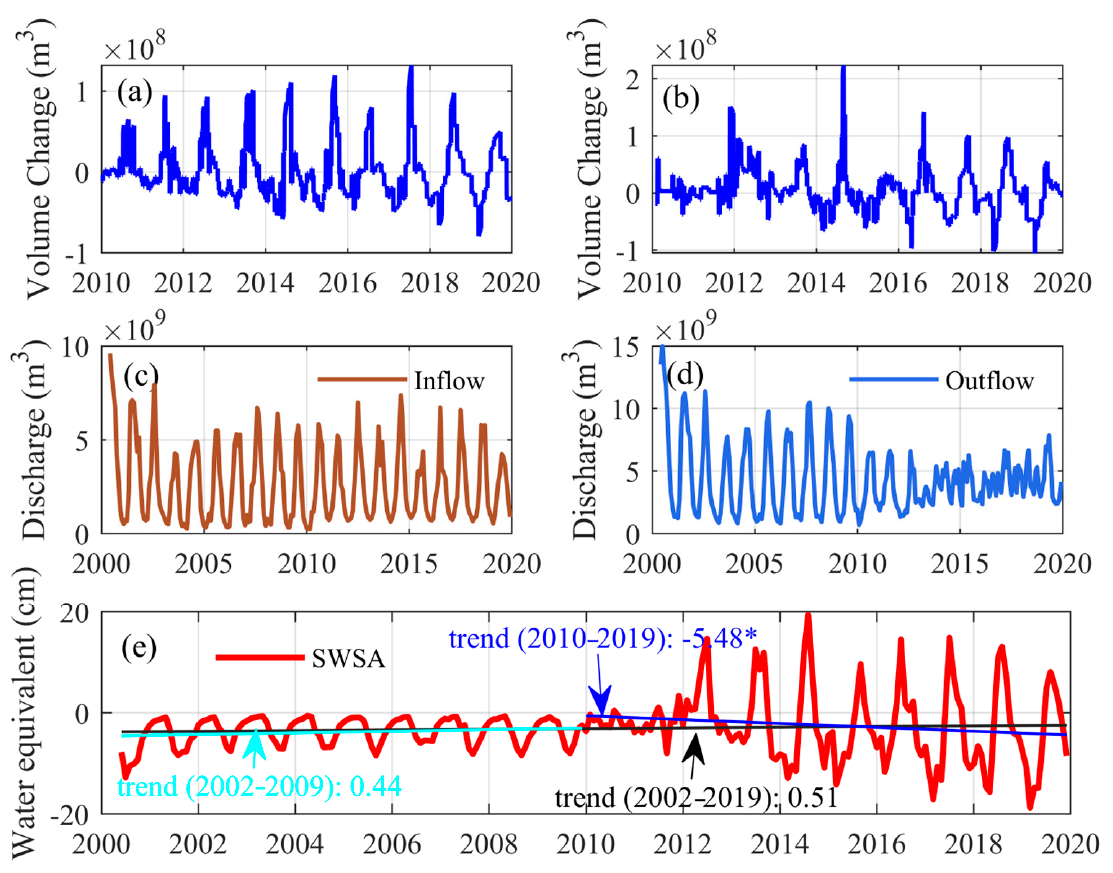
Figure 6. The variations of volume change in ( a ) Xiaowan and ( b ) Nuzohadu. The variations of ( c ) the inflow and ( d ) outflow in the study region. ( e ) The variations of the surface water storage anomaly (SWSA) in the study region. The unit of trend is cm/yr. Asterisk (*) refers to statistically significant values ( p -value < 0.05).